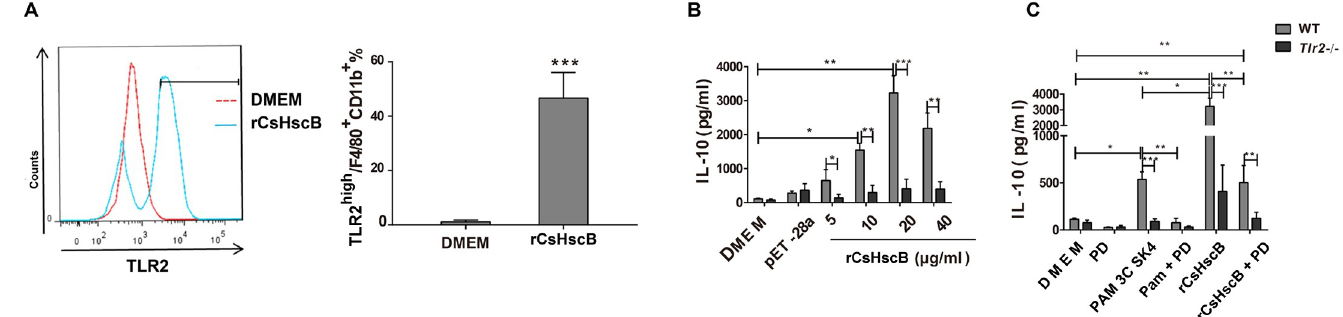
Fig 5. rCsHscB-induced IL-10 production depends on TLR2-mediated ERK1/2 signaling in bone marrow-derived macrophage. (A) Flow cytometry analysis of TLR2 high F4/80 + CD11b + in DMEM stimulated and rCsHscB-stimulated BMDMs from TLR2 wild type mice. (B) ELISA analysis of IL-10 production in BMDMs cells from TLR2 wild type and Tlr2 -/- mice stimulated with various concentrations of rCsHscB as indicated. DMEM as negative control. pET-28 group represents supernatant of lysate from E . Coli transfecting with pET-28a empty vector. (C) ELISA analysis of IL-10 production in BMDMs cells from TLR2 wild type and Tlr2 -/- mice stimulated with rCsHscB (20 μ g/ml) with or without of ERK1/2 inhibitor (PD98059). PM 3 CSK 4 was used as TLR2 ligand for positive controls. Quantitative data are representative of mean ± SEM of at least three independent experiments (n = 4). � P < 0.05, �� P < 0.01, and ��� P < 0.001 compared with indicated group.